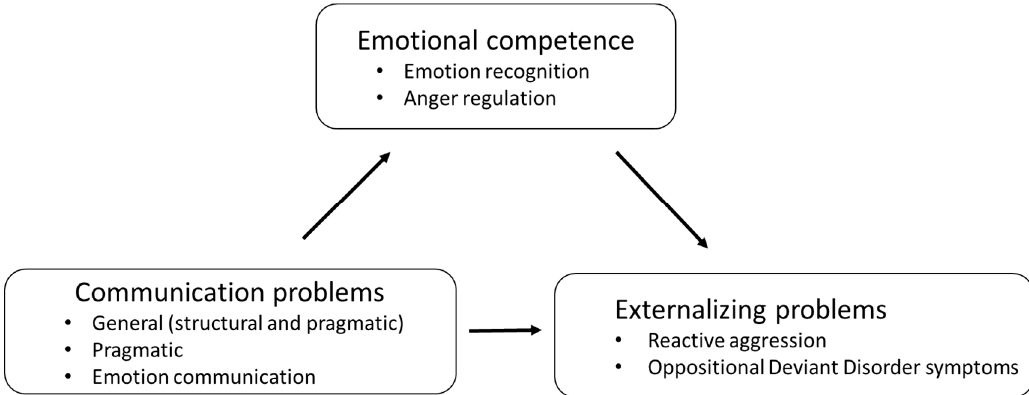
Figure 1. Emotional competence as a mediator between communication problems and reactive externalizing